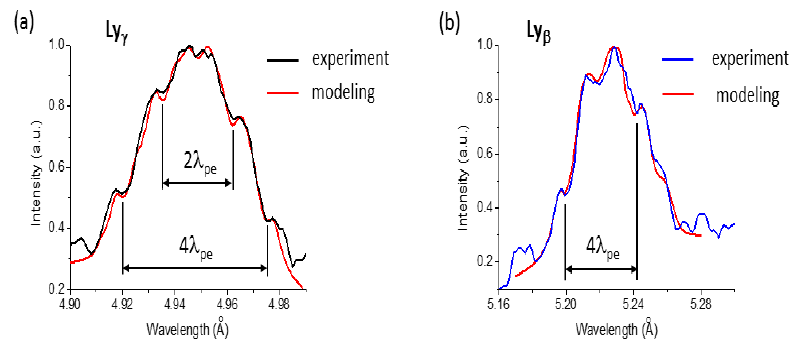
Figure 3. Experimental spectra and their comparisons with a different Stark broadening code including L-dips and the spectral line broadening by LET. ( a ) Experimental spectra of Si XIV Ly γ line in a single laser shot with initial laser intensity at the surface of the target estimated as 1.01 × 10 21 W/cm 2 initial laser intensity at the surface of the target. The positions of the dips/depressions in the profiles are marked by vertical lines separated either by 2 λ pe or 4 λ pe , where λ pe = [ λ 02 /(2 π c )] ω pe ( λ 0 is the unperturbed wavelength of the corresponding line). Also shown is a theoretical profile at N e = 3.6 × 10 22 cm − 3 allowing, in particular, for a low-frequency electrostatic turbulence. ( b ) Same but for Si XIV Ly β line in a single laser shot with initial laser intensity at the surface of the target estimated as 0.24 × 10 21 W/cm 2 initial laser intensity at the surface of the target. The theoretical profile is shown at N e = 1.74 × 10 22 cm − 3 [12].